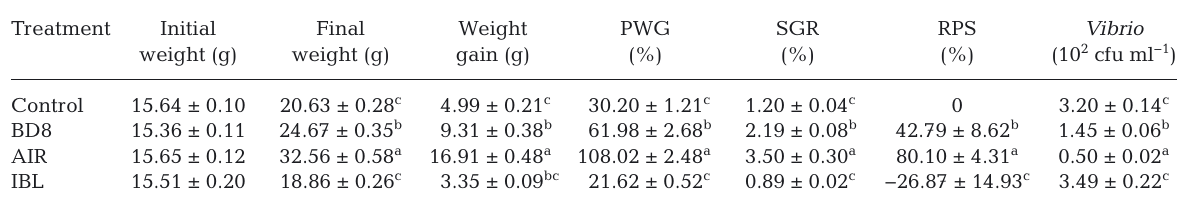
Table 3. Growth performance of grass carp challenged with Vibrio parahaemolyticus for 22 d. Data are means ± SD. BD8: inoc- ulation levels of Bacillus subtilis D9 at 5.5 × 10 8 cfu ml −1 ; AIR: BD8 under the aeration treatment; IBL: BD8 with an inactivated bacteria liquid; PWG: percentage of weight gain; SGR: specific growth rate; RPS: relative percentage of survival. Within columns, means with the same superscript letters are not significantly different (Tukey’s post hoc test, p > 0.05)